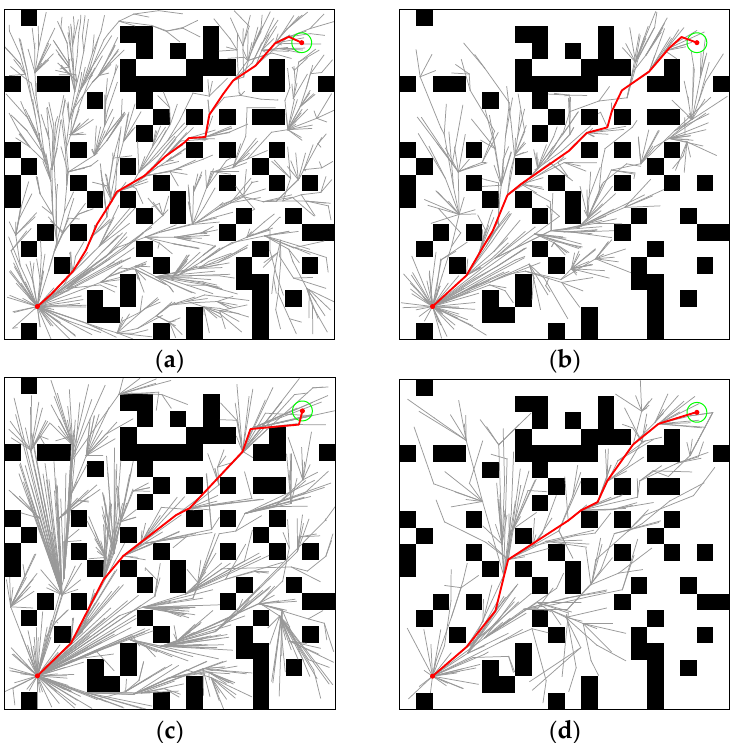
Figure 12. Performance of the four algorithms in the cluttered environment. ( a ) RRT*. ( b ) Informed- RRT*. ( c ) Q-RRT*. ( d ) M-RRT*. (Red line: approximate optimal path, green circle: goal